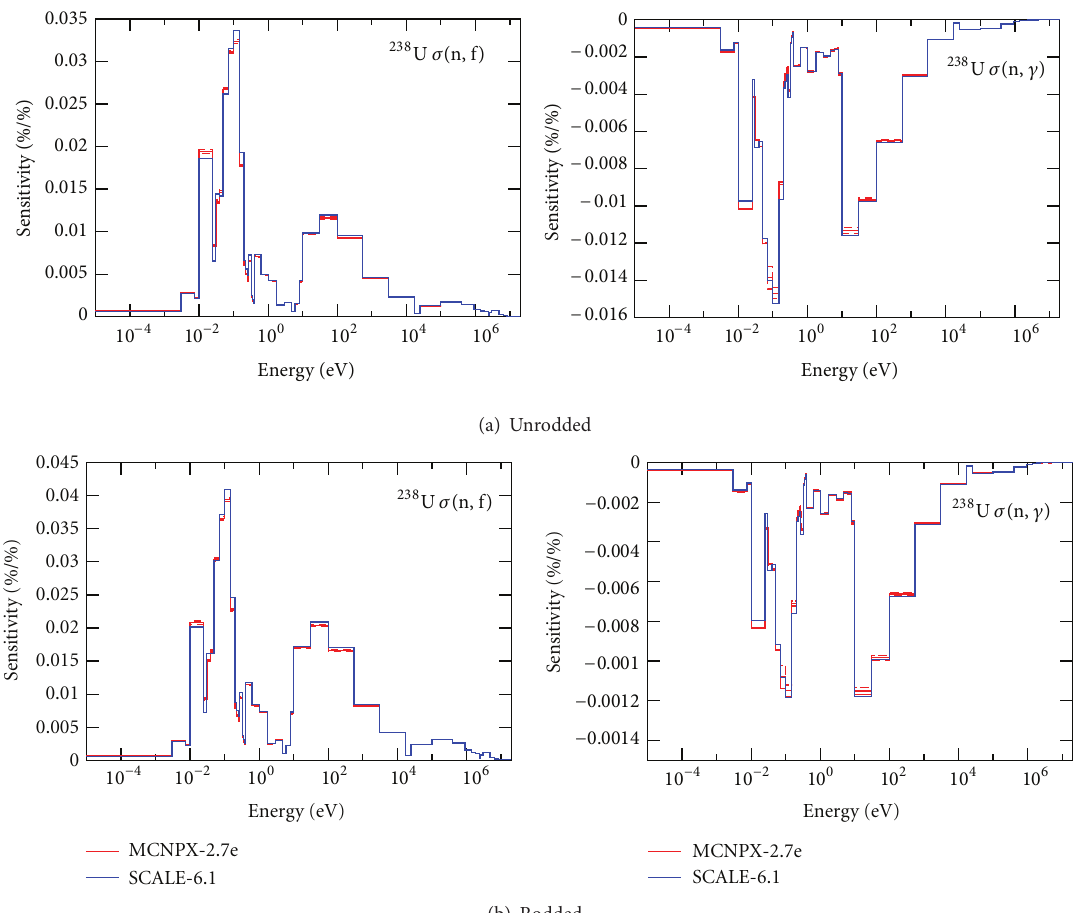
Figure 4: Sensitivity profiles of 235 U reaction cross sections calculated by MCNPX-2.7e and SCALE-6.1 for unrodded and rodded cases at